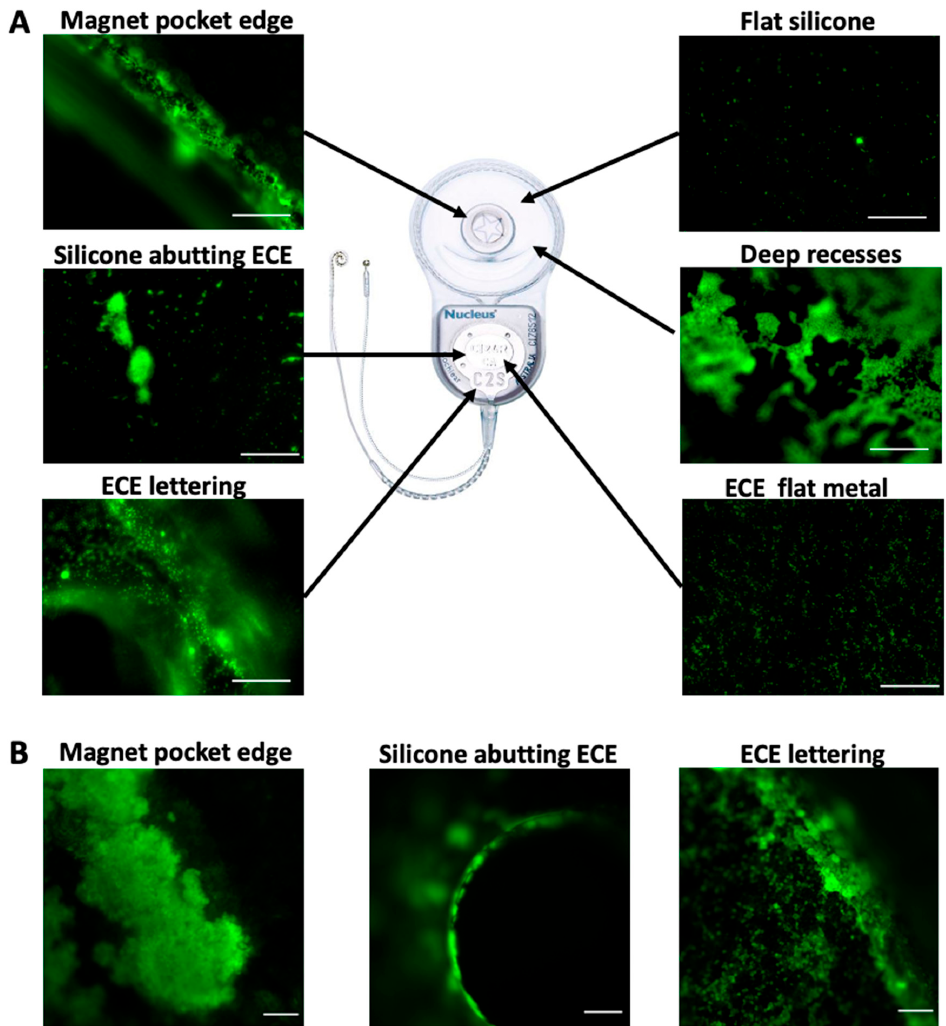
Figure 1. Imaging of bacterial biomass on cochlear implant devices. ( A ) Attachment of S. aureus to CI24RE devices in in vitro assays visualized with Syto-9 (green) stain. ( B ) CI24RE devices explanted due to infection visualized using a general eubacterial FISH probe (green) . Imaged regions are as follows: magnet pocket edge, silicone abutting extracochlear electrode (ECE), ECE lettering, ECE flat metal, deep recesses, or flat silicone. Scale bar is 100 μ m for all images. Images are representative of ( A ) ten or ( B ) four devices.